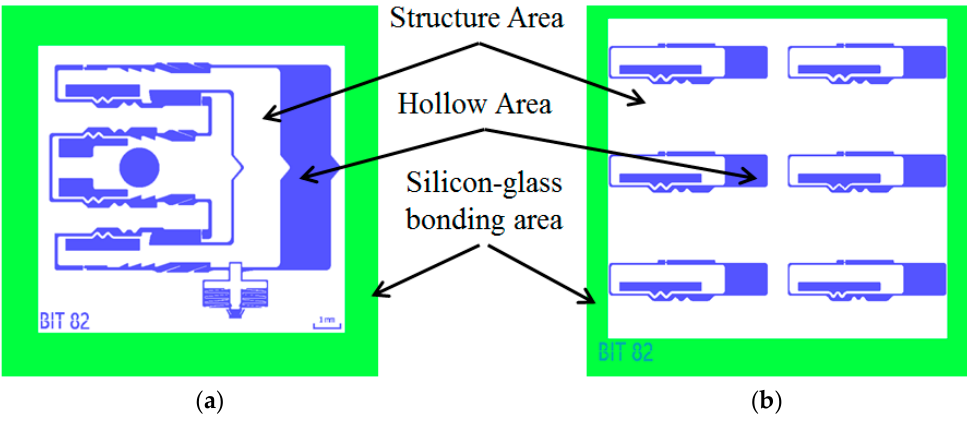
Figure 11. The processing layout ( a ) MEMS S&A system, ( b ) Elastic-beam delaying mechanism.